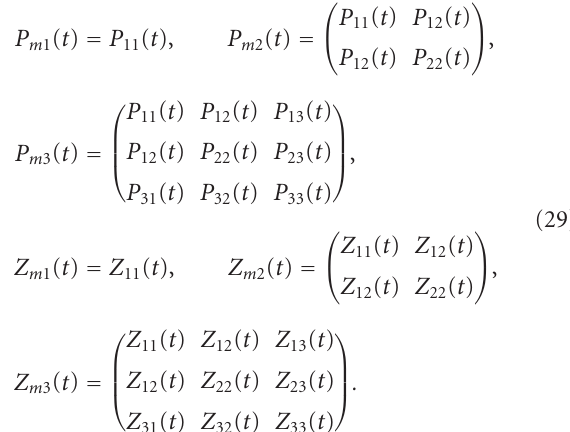
where b 1 = 1 × 10 − 3 [N · m] and b 2 = 2 × 10 − 3 [N · m] are the disturbance levels at first and second joints,